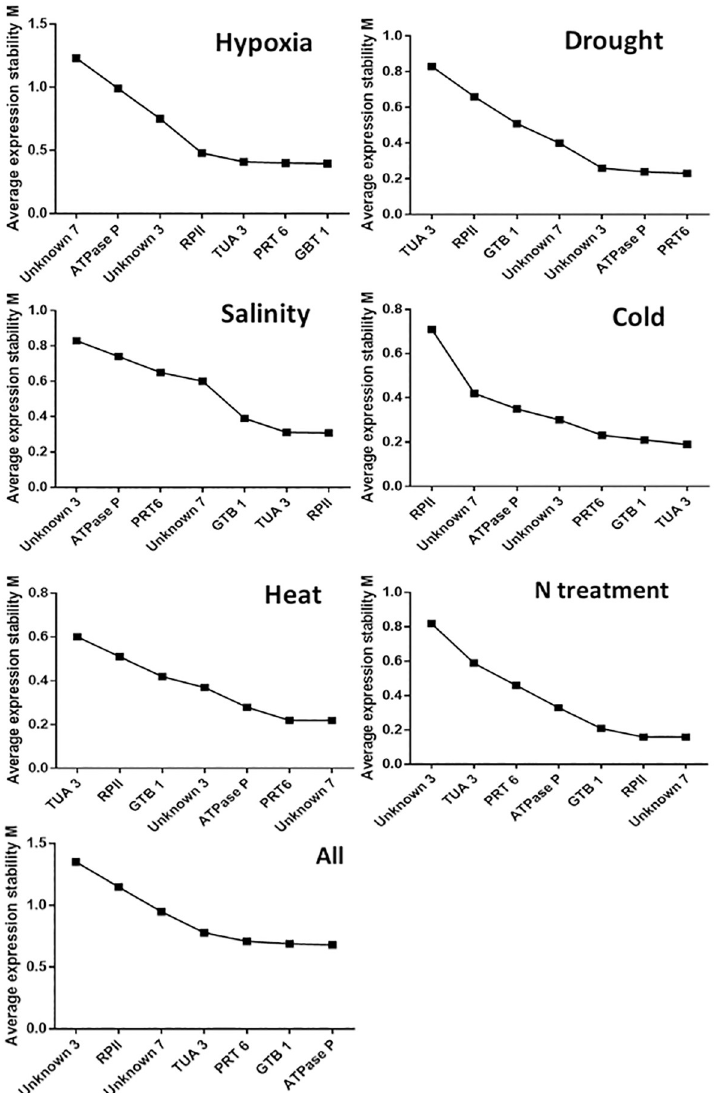
Fig 2. Average expression stability (M value) of the seven selected protein-coding candidate housekeeping genes using geNorm software. Expression stability was evaluated in samples from Prunus spp. under drought, salinity, cold, heat, N treatment and all together, plus the results of hypoxia. A lower average expression stability M value indicates more stable expression.